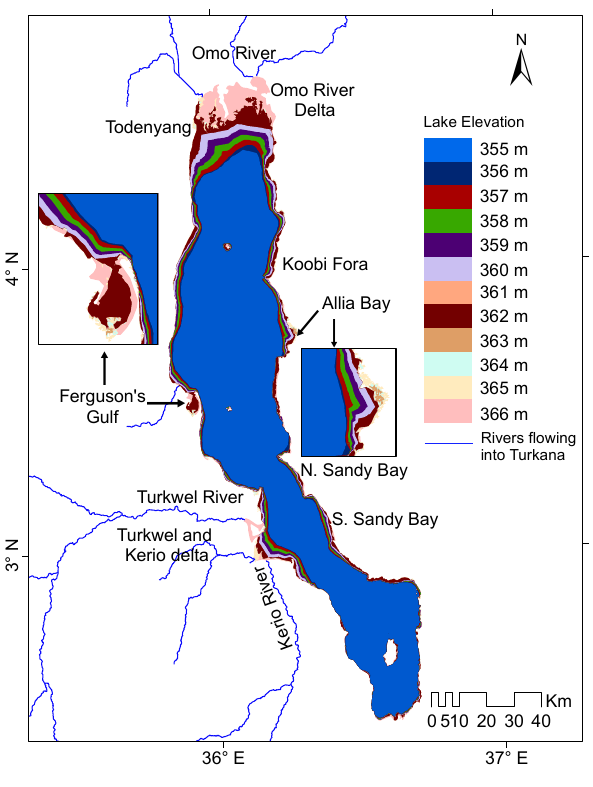
Fig. 9. Lake Turkana water levels at various depths. The shallow regions along the lake shoreline show the most productive fishing